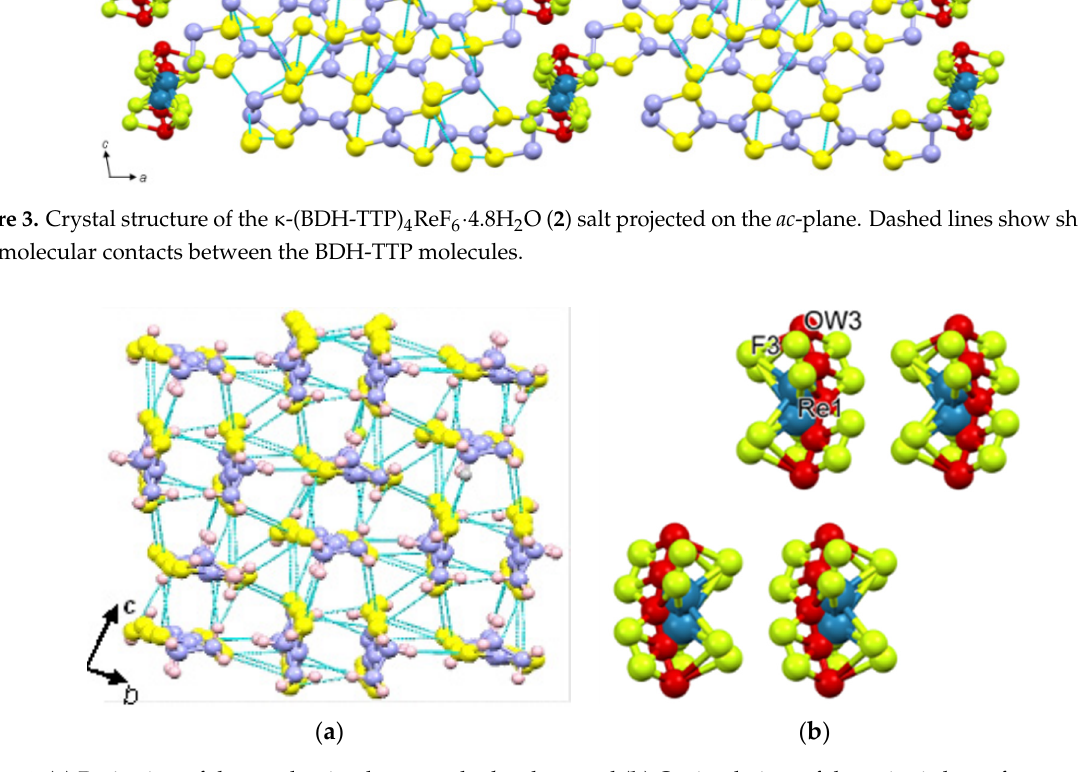
Figure 4. ( a ) Projection of the conducting layer on the bc- plane and ( b ) Optimal view of the anionic layer fragment in the κ -(BDH-TTP) 4 ReF 6 ·4.8H 2 O ( 2 ) salt.